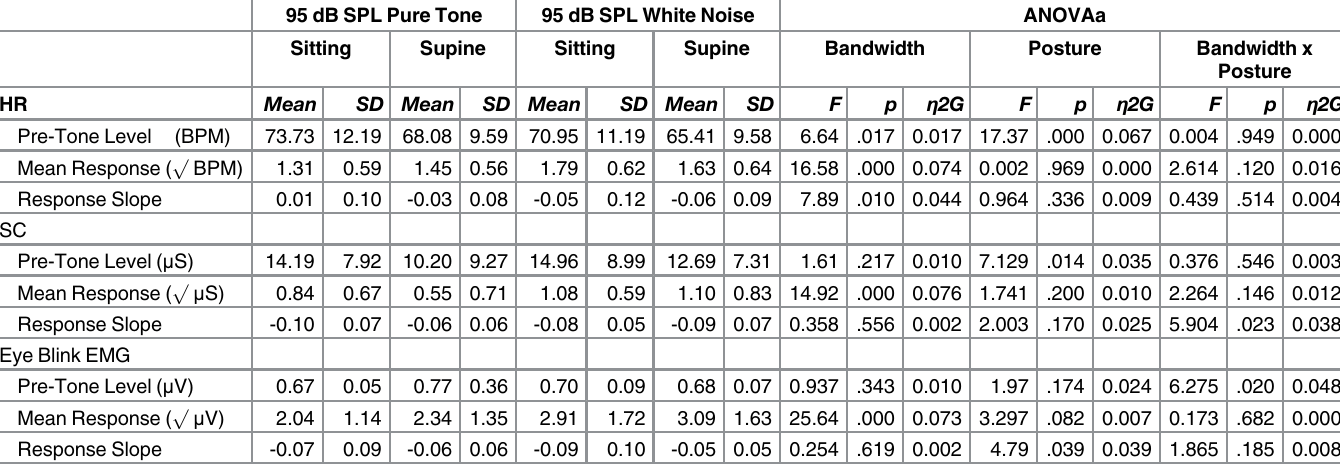
Table 2. Peripheral Physiological Responses to Sound Presentations by Stimulus Bandwidth and Subject ’ s Posture (N = 24). 95 dB SPL Pure Tone 95 dB SPL White